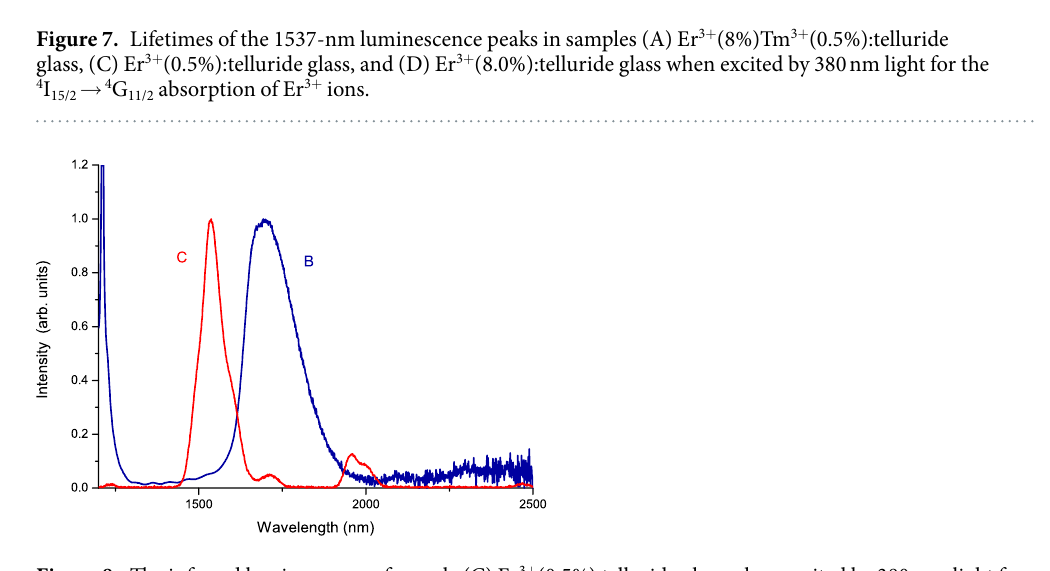
Figure 8. The infrared luminescence of sample (C) Er 3 + (0.5%):telluride glass when excited by 380-nm light for the 4 I 15/2 → 4 G 11/2 absorption of Er 3 + ions and the infrared absorption of sample (B) Tm 3 + (0.5%):telluride